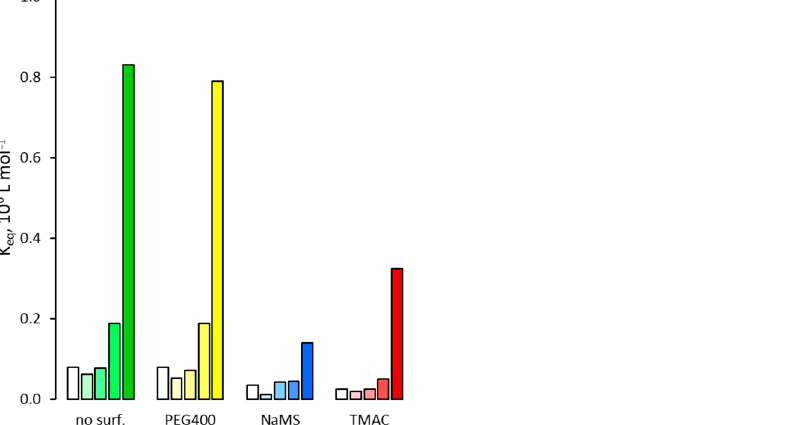
Table S2: SDS, binding affinity values; Table S3: CTAB, binding affinity